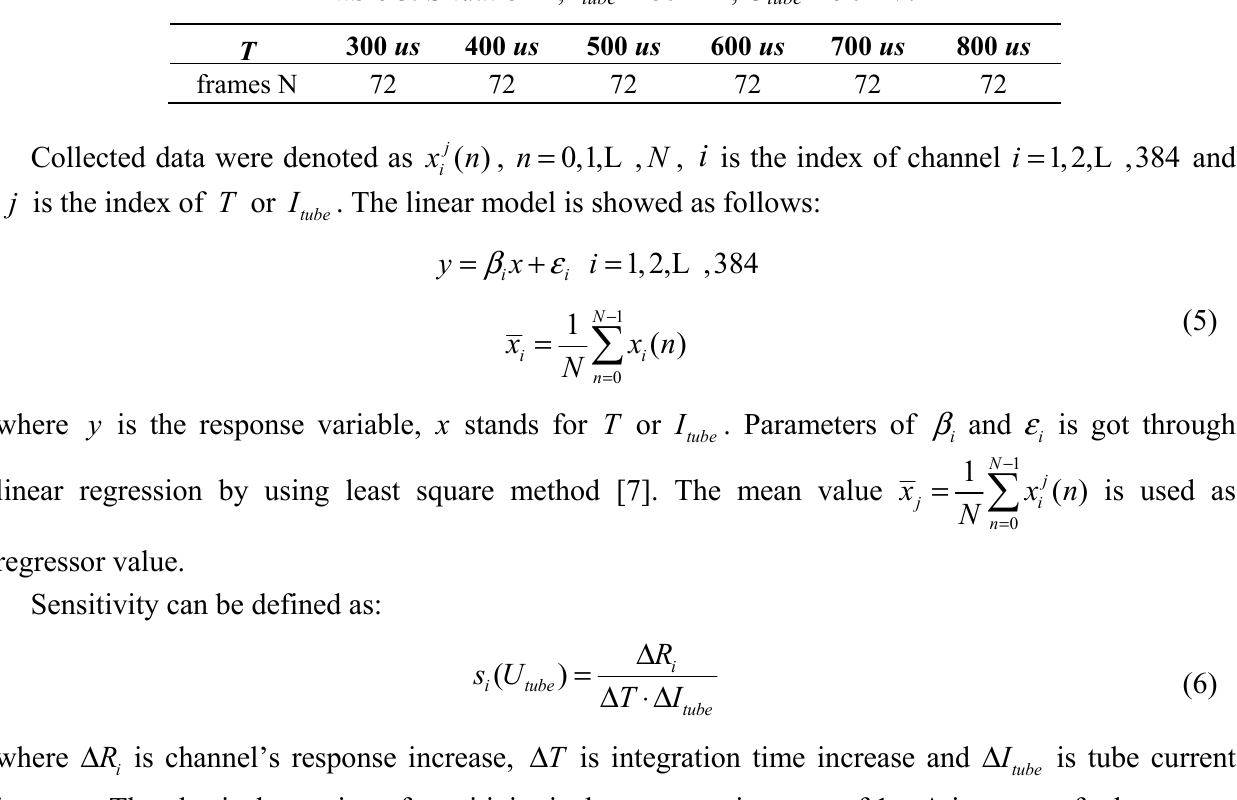
Table 5. Situation 2, I